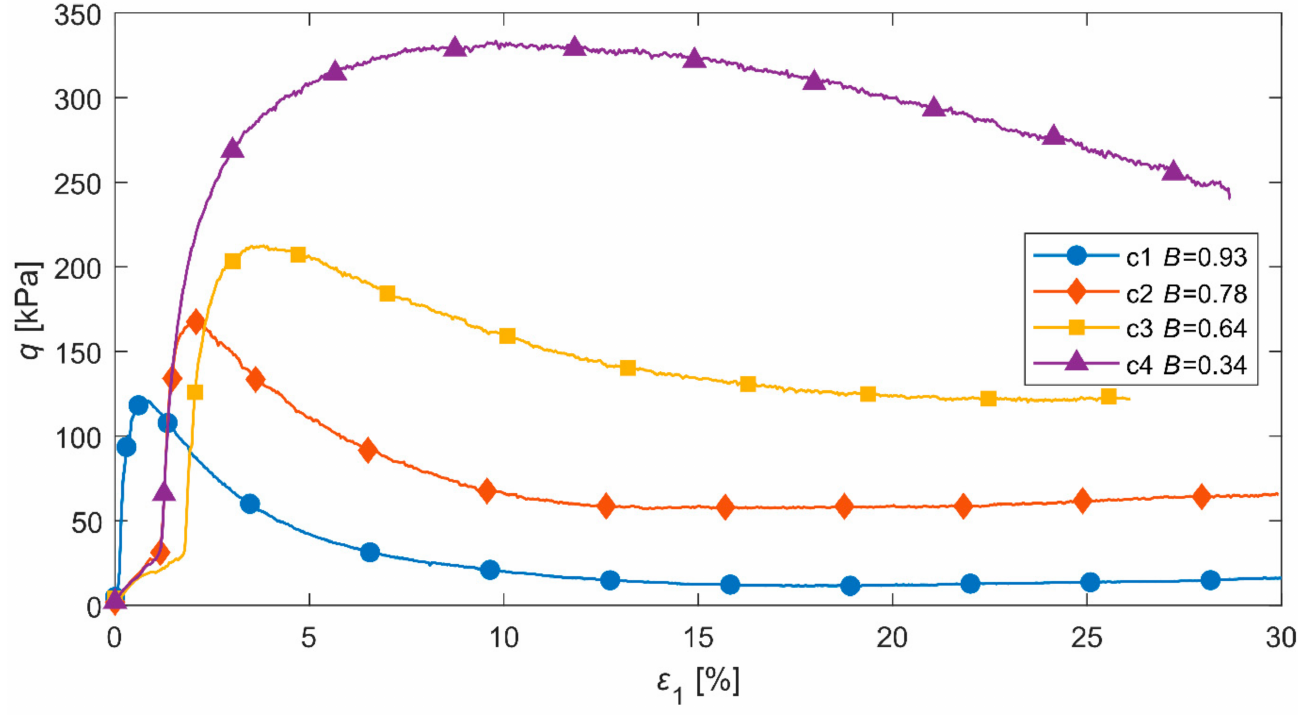
Figure 12. Stress–strain response of Skarpa sand at different levels of saturation: stress deviator vs. axial